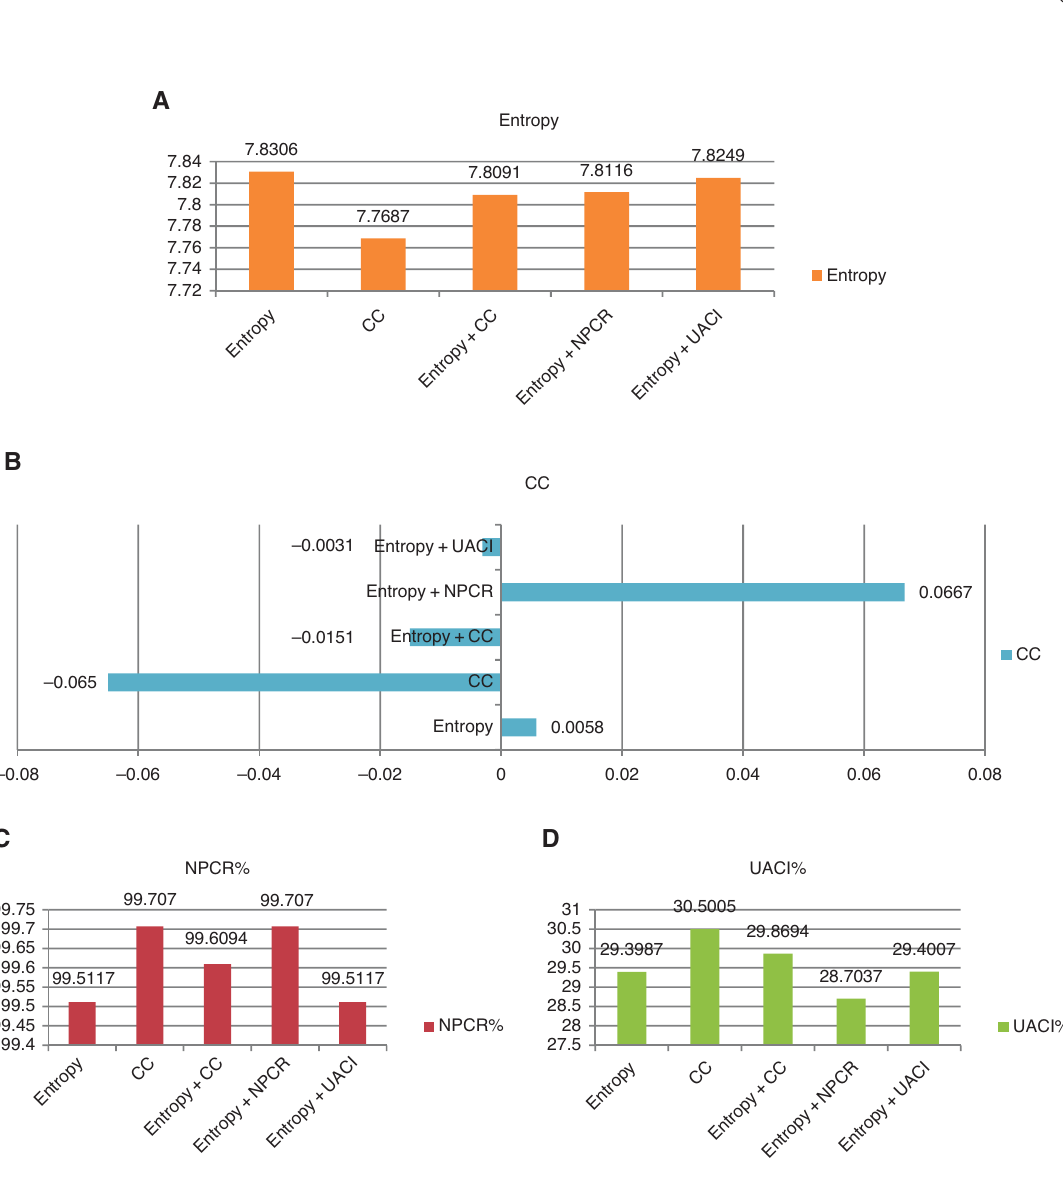
Figure 5: Comparative Analysis for Coin Image Using Logistic Map Function. (A) Entropy for coin image; (B) CC for coin image; (C) NPCR for coin image; (D) UACI for coin